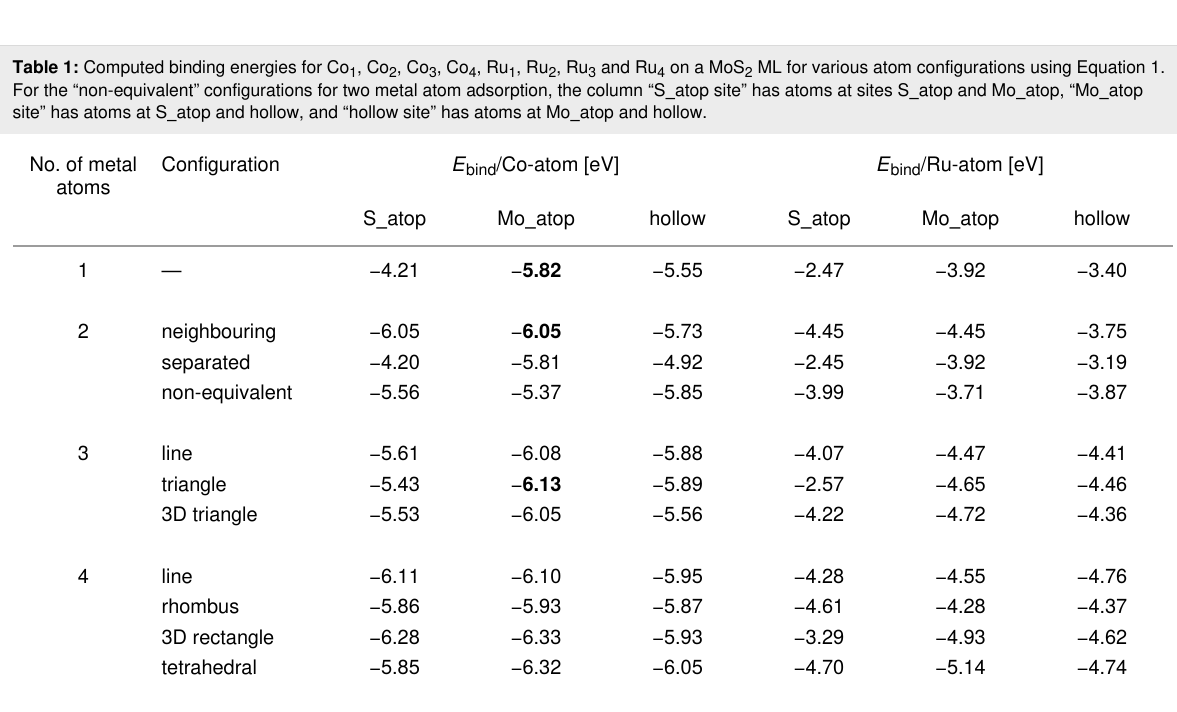
Figure 1: Atomic structure and energies of Co 1 adsorption modes on perfect MoS 2 . Mo is shown in teal, S in yellow, Co in pink and Ru in purple throughout the article.